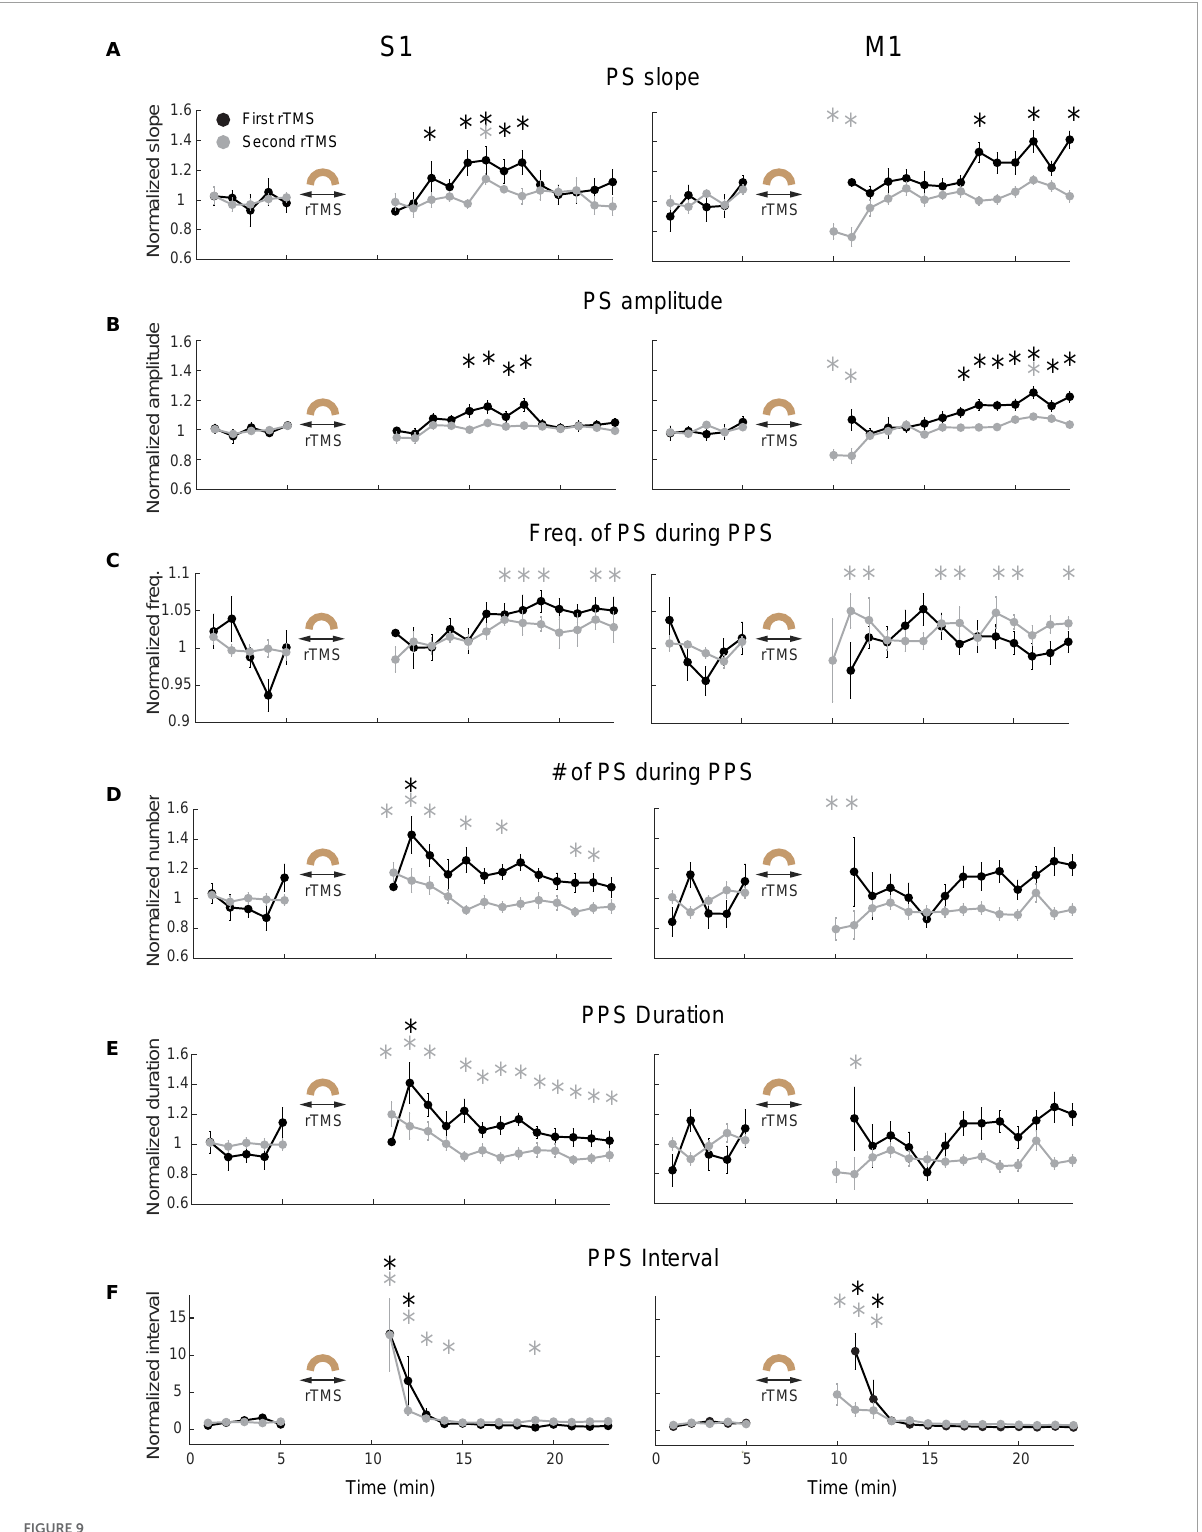
FIGURE9 Changes of PPS features after the first (black) and second (gray) courses of rTMS in S1 (left) and M1 (right). (A) Slope of population spikes (PS) during PPS. (B) Amplitude of PS during PPS. (C) Frequency of PS during PPS. (D) Number of PS during PPS. (E) PPS duration. (F) PPS-PPS intervals. All values were normalized and compared with the baseline recordings (* p < 0.05, two-tailed t -test). Error bars: